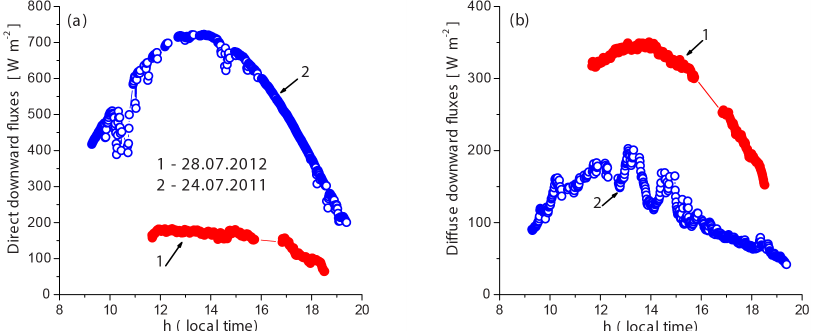
Figure 4. Daytime behaviour of (a) direct and (b) diffuse fluxes of solar radiation under the usual conditions (24 July 2011) and during extreme smoke conditions (28 July 2012) in the region of the Fonovaya